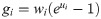
The halving of the victory reward based on the utility and quantitative criteria in the hawk-dove game.(a) Payoff matrix of the hawk-dove game, where V and C are the victory reward and fighting cost, respectively. (b, c, d) The halving outcomes of victory rewards (V) by two players adopting the dove strategy in which the current wealth of player 1 (rich dove; RD) and player 2 (poor dove; PD), w1 and w2, are w1 = 10 and w2 = 5. (b) The utility criterion in which V = 2 (utility) is divided by half, such that u1 = u2 = 1. The amount gained by each player is proportional to the player’s current wealth, such that gi=wi(eui−1). The total amount, G, of victory reward, V, varies based on the sum of the current wealth of both players, such that G = (w1 + w2)(e– 1). (c) The utility criterion in which the amount of reward G is set constant (G = $2). The gains of the players depend on the proportion of players’ current wealth, such that g1 = {w1/(w1 + w2)}G. The utilities of the two players are equal, but the amounts of gains differ based on the ratio of current wealth, as in (b). (d) The quantitative criterion in which V = G = 2 dollars. The utility of players depends on the current wealth of players, such that ui = log {(gi + wi)/wi}.